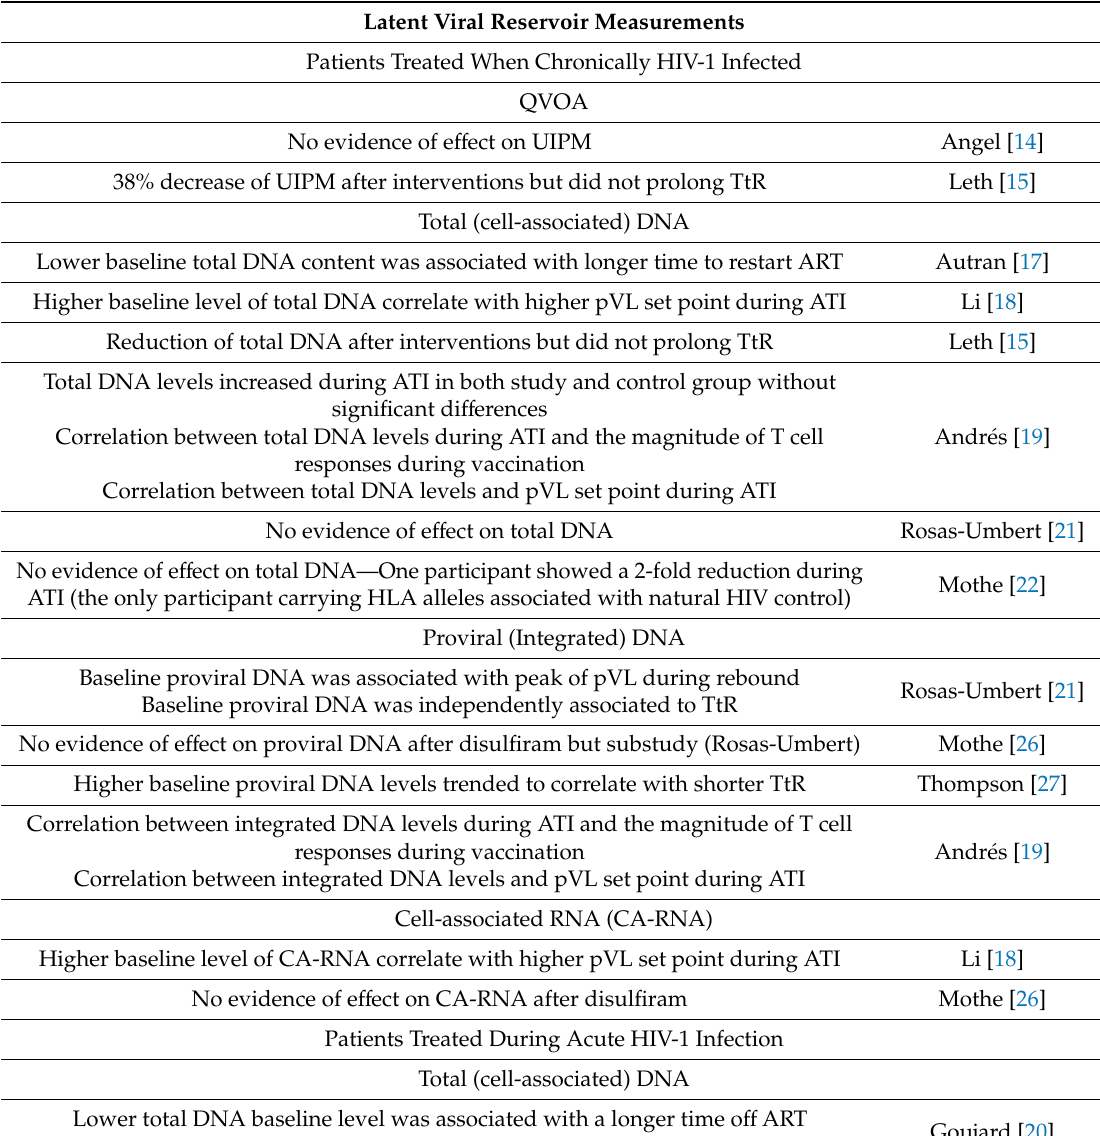
Table 4. Evidence summary of latent HIV-1 reservoir e ff ect on viral load